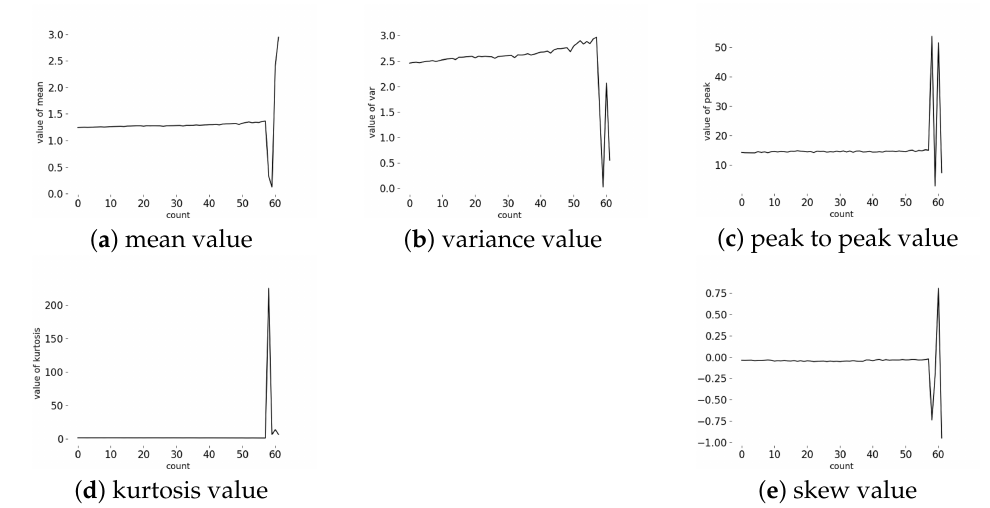
Figure 5. Time domain analysis with time span of one minute.